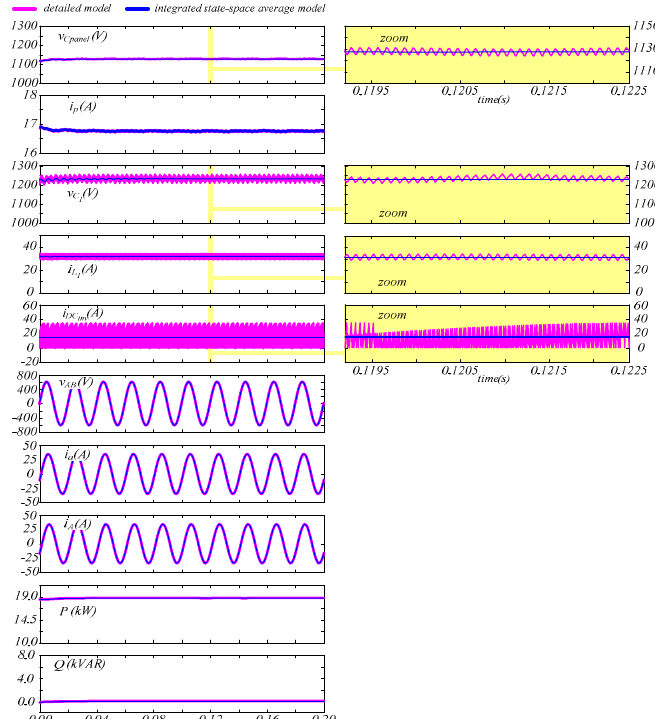
Figure 9. Simulation of a 18.9 kW PV subfield (2 strings in parallel, each string is composed by the series connection of 30 315 W PV modules). PV system topology is represented in Figure 5, technical data of components are listed in Table 2. Irradiance is 1000 W/m 2 , module temperature is 25 °C. Comparison between detailed model and integrated state-space average model. Table 3. Parameters list for the simulation shown in Figure